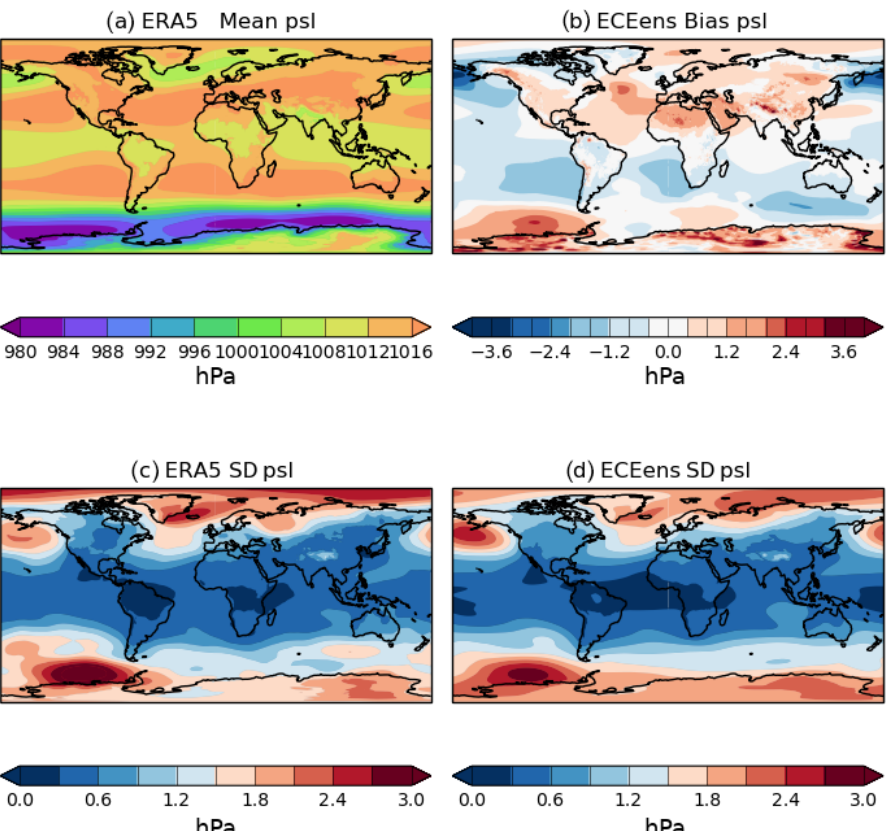
Figure 7. Upper panel: mean PSL 1980–2010 (hPa) for ERA5 (a) and for the EC-Earth3 ensemble bias compared to ERA5 (b) . Lower panel: interannual standard deviation (hPa) for ERA5 (c) and for the EC-Earth3 ensemble (d)